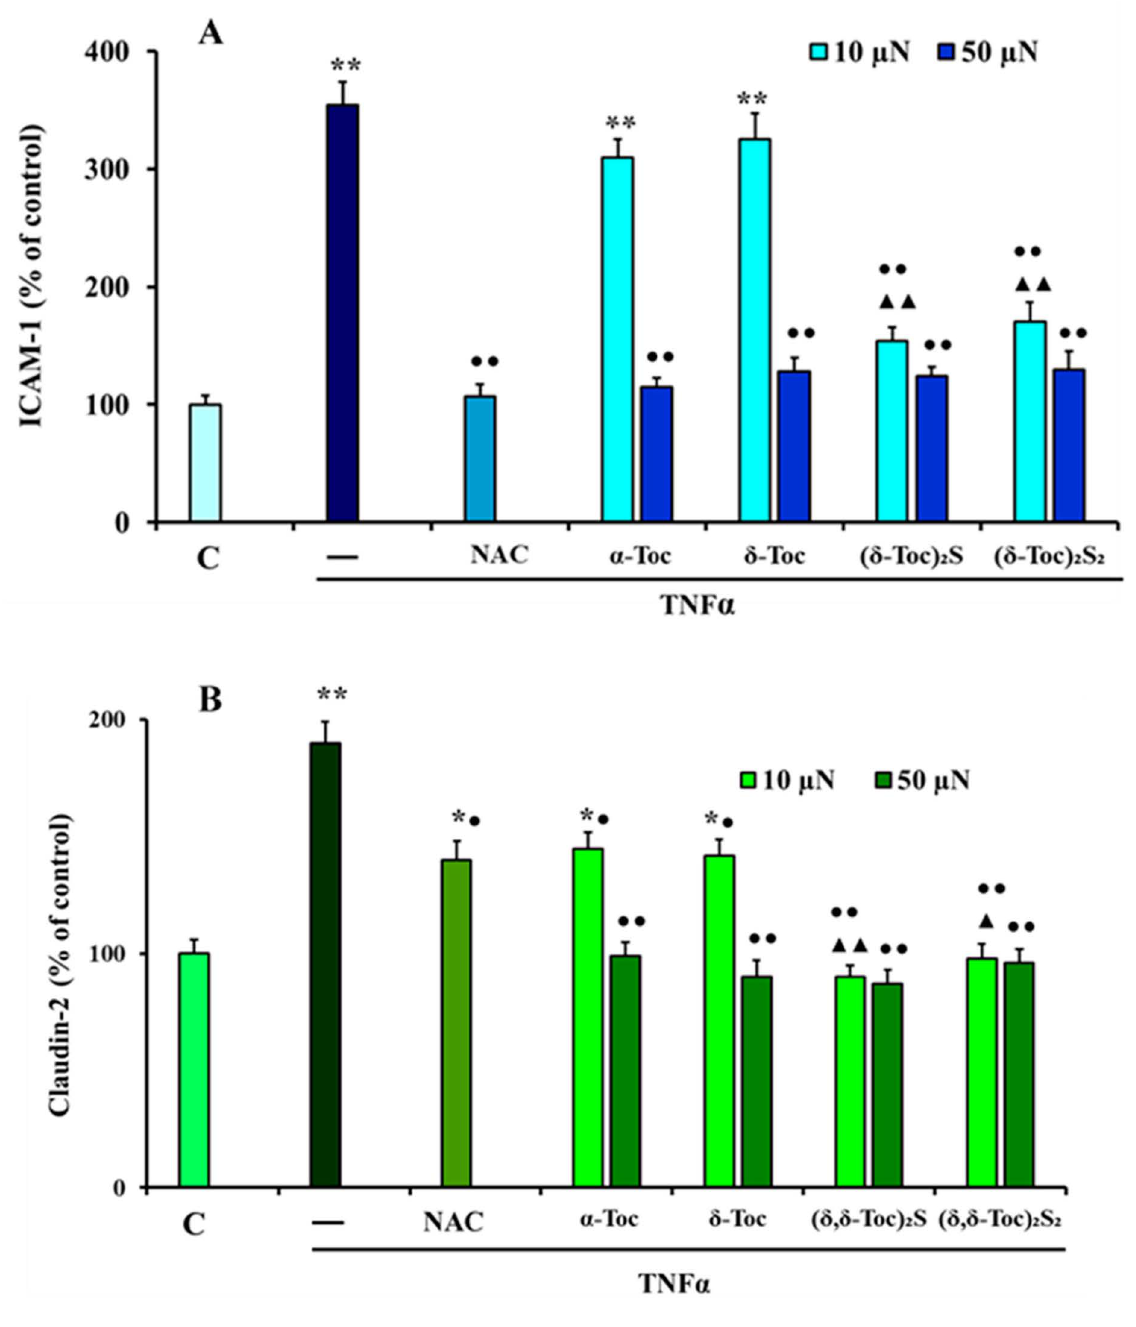
Figure 5. ICAM-1 and Cl-2 expression in HT29 cells pre-treated or not with natural, α -Toc , δ -Toc , semi-synthetic, ( δ -Toc) 2 S , ( δ -Toc) 2 S 2 , or NAC, and stimulated with TNF α . HT29, pre-treated or not with various concentrations (10–50 µ N) of α -Toc , δ -Toc , ( δ -Toc) 2 S , ( δ -Toc) 2 S 2 , or 20 mM NAC, as reported in Materials and Methods, were stimulated or not for 24 h with 10 ng/mL TNF α . ICAM-1 levels ( A ) and Cl-2 levels ( B ) were assayed by ELISA kits in cell lysates. The values, expressed as the percentage of untreated and unstimulated cells (control, C), are the mean ± SEM of three experiments repeated in triplicate. * p ≤ 0.05, ** p ≤ 0.001 compared to C cells; • p ≤ 0.05, •• p ≤ 0.001 compared to untreated and TNF α -stimulated (cid:78) p ≤ (cid:78)(cid:78) p ≤ cells; 0.05, 0.001 compared to α -Toc and δ -Toc pre-treated, and TNF α -stimulated